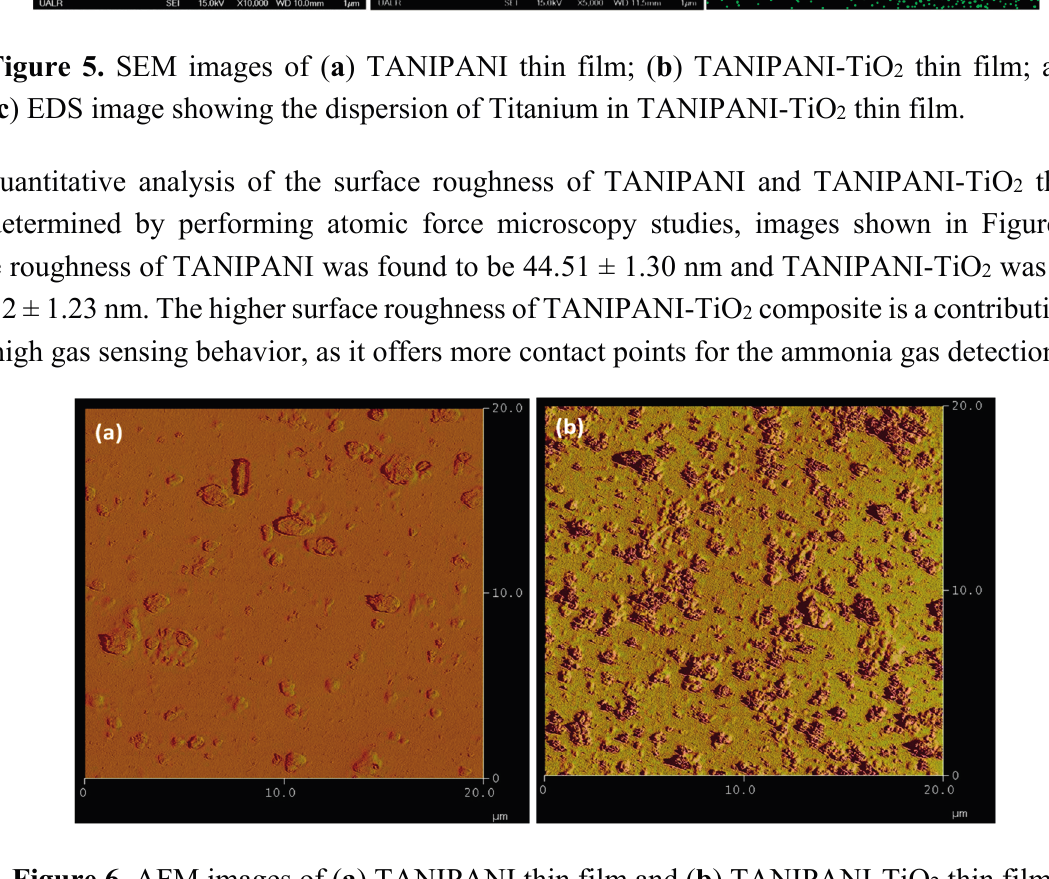
Figure 6. AFM images of ( a ) TANIPANI thin film and ( b ) TANIPANI-TiO 2 thin